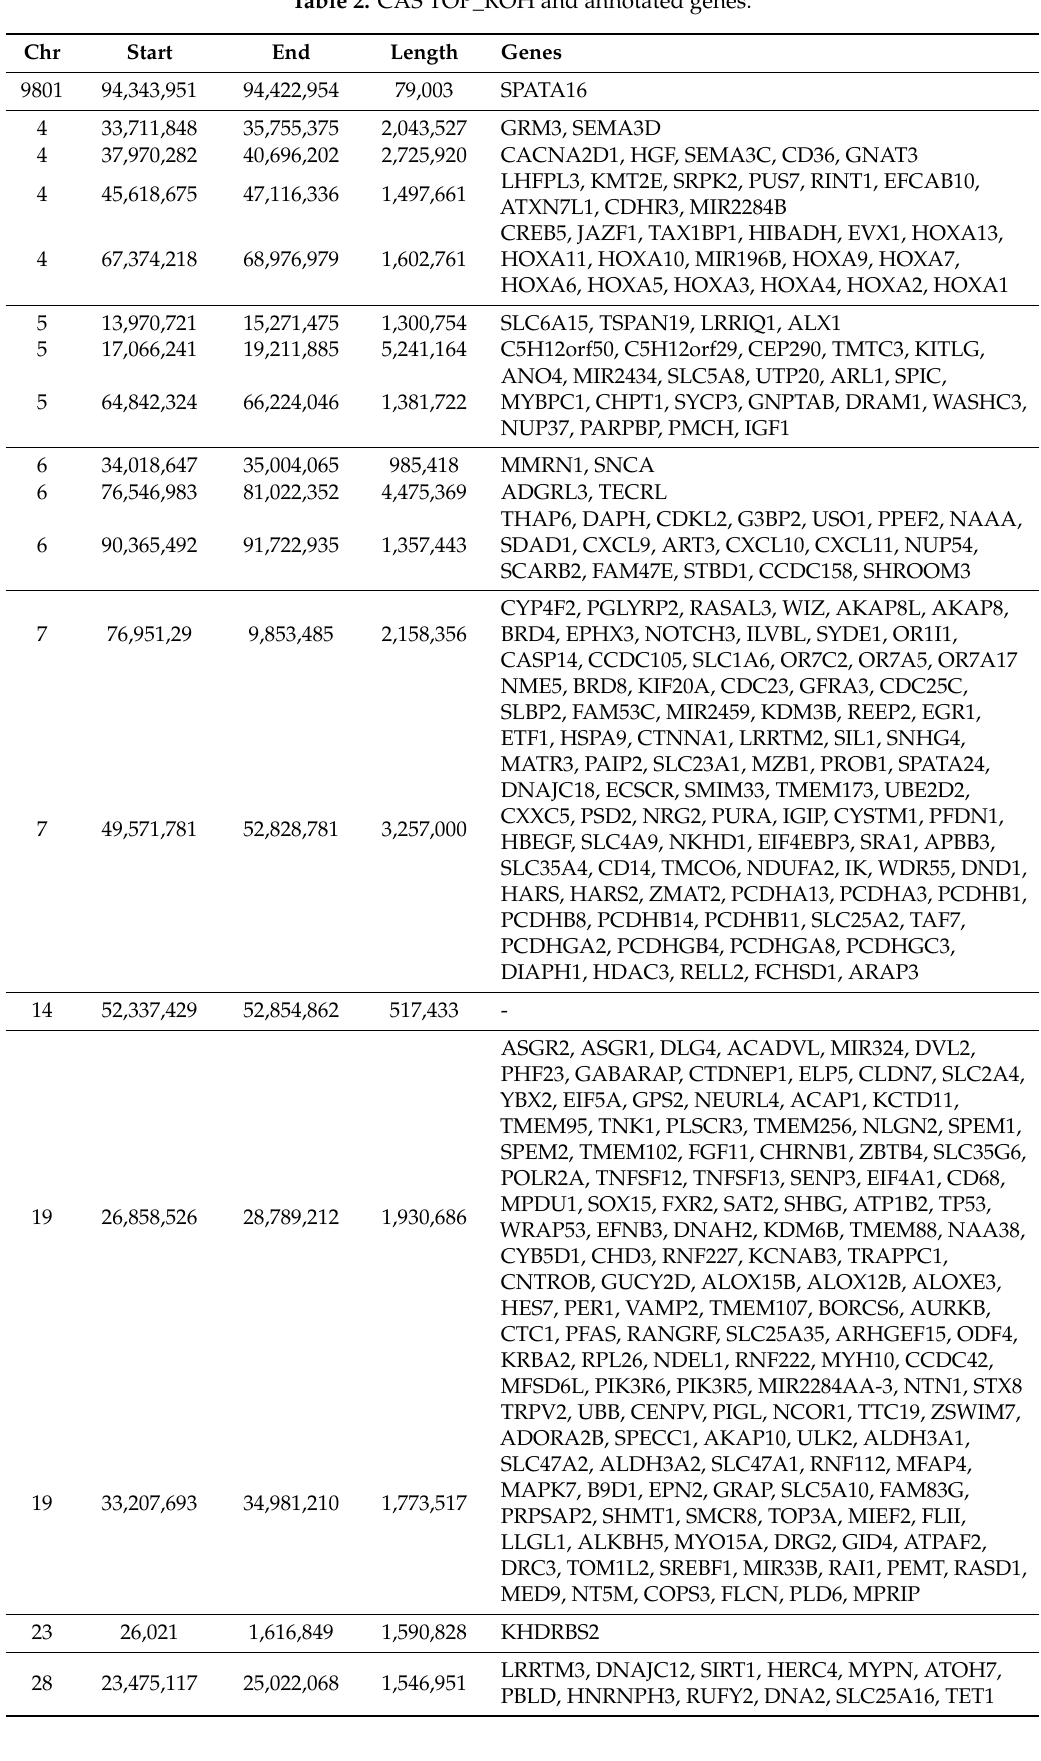
Table 2. CAS TOP_ROH and annotated